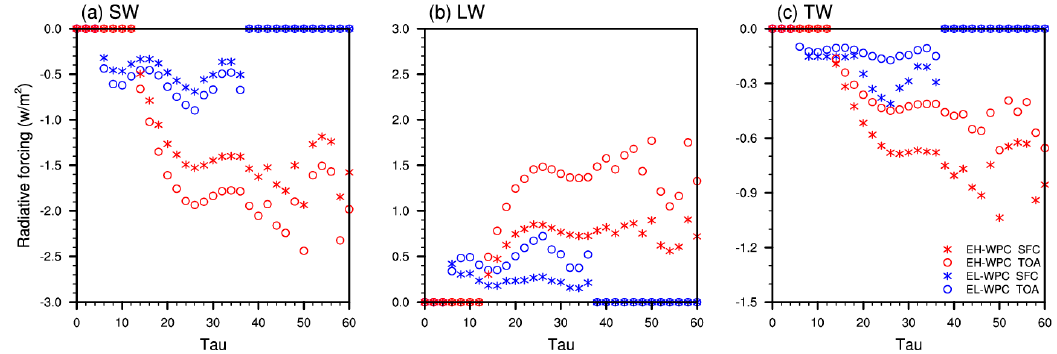
Figure 9. Relationships of ( a ) shortwave (SW), ( b ) longwave (LW) and ( c ) total (TW) net radiative forcing with cloud optical depth (Tau) for extreme-light (EL-WPC) and extreme-heavy (EH-WPC) warm precipitating cloud at top of atmosphere (TOA) and surface (SFC).